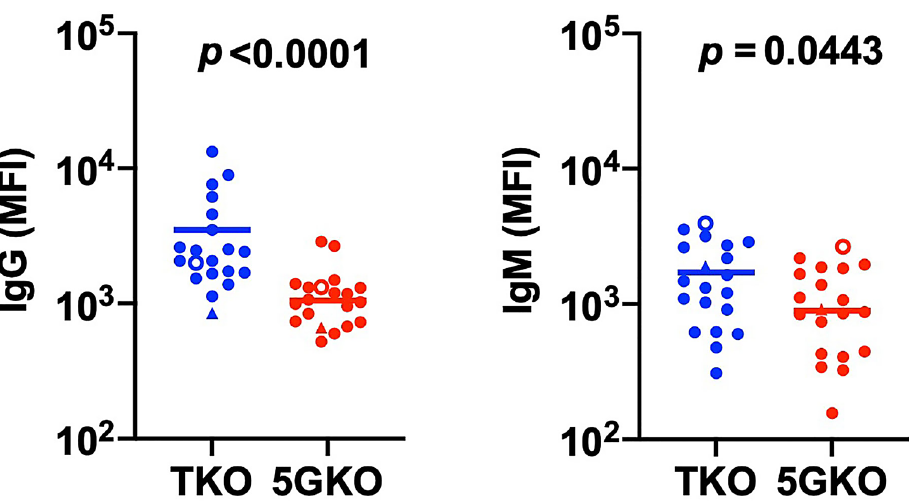
Figure 5. Comparison of human serum antibody binding to TKO and 5GKO ipLDEC lines. Human sera from 20 patients on the kidney transplant wait-list were incubated with TKO ( GGTA1/CMAH/β4galNT2 ) or 5GKO ( GGTA1/CMAH/ β4galNT2/SLA-I α chain/B2M ) ipLDEC. Subsequently, fluorescent conjugated anti-human IgG or IgM was used to evaluate human IgG or IgM binding to the cells, with mean fluorescence intensity (MFI). Mann–Whitney test was used to analyze the differences between TKO and 5GKO ipLDEC lines. Human serum IgG exhibited significantly decreased binding to 5GKO ipLDEC compared to TKO ipLDEC ( p < 0.0001). Human serum IgM binding to 5GKO ipLDEC was also significantly reduced compared to TKO ipLDEC, ( p = 0.0443). Unfilled dots and triangles represented low PRA (< 10%) serum samples (n = 2). All other serum samples (n = 18) shown in dots were from individuals with high PRA (>